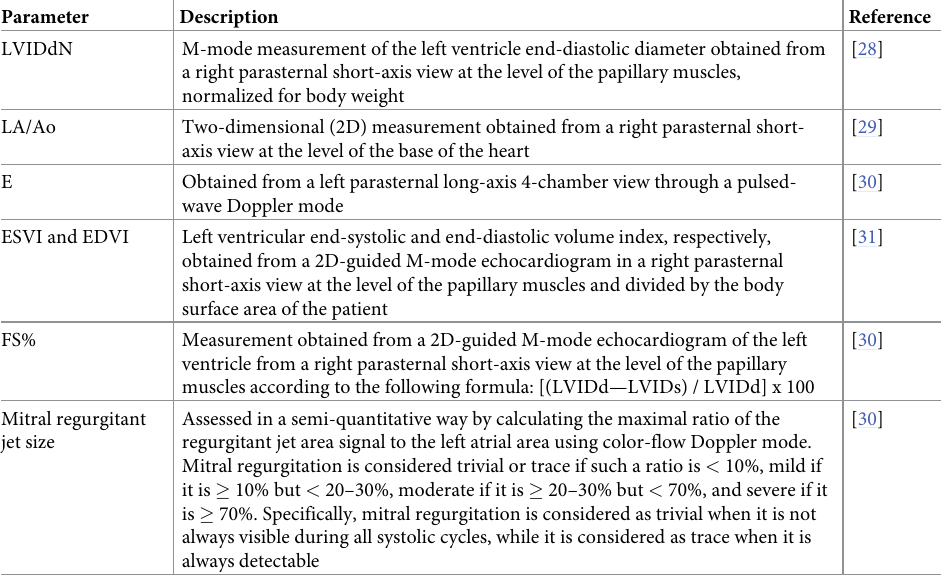
Table 1. List of the echocardiographic parameters analyzed in this study, and description of how they were obtained.